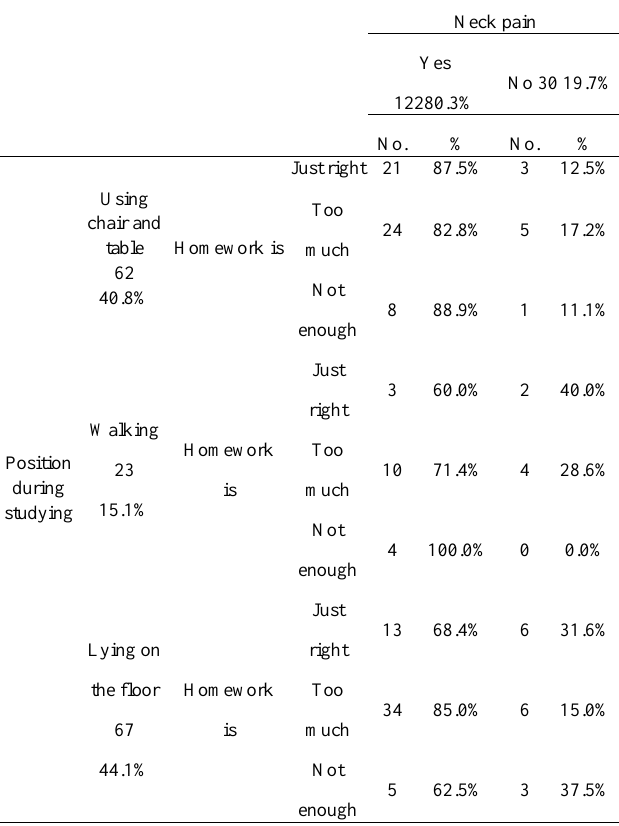
Table (3): Show the correlation between position of students during studying